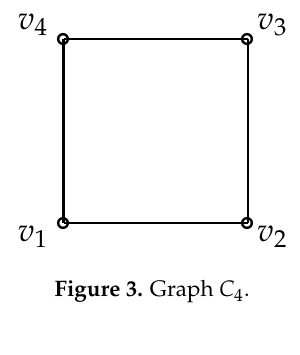
Figure 3. Graph C 4